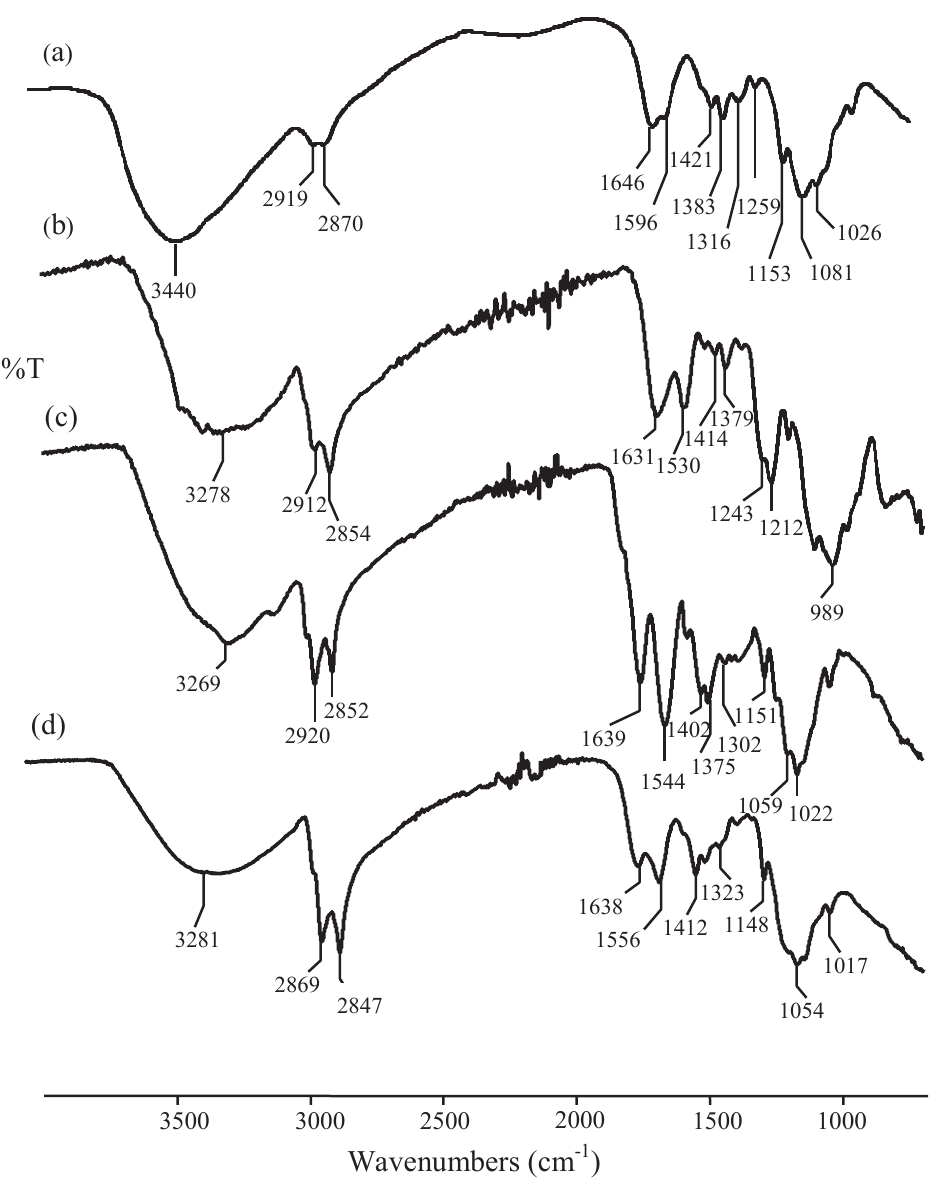
Figure 2: FTIR spectra of (a) chitosan, (b) NOOSC, (c) NONSC and (d) NOOGC .